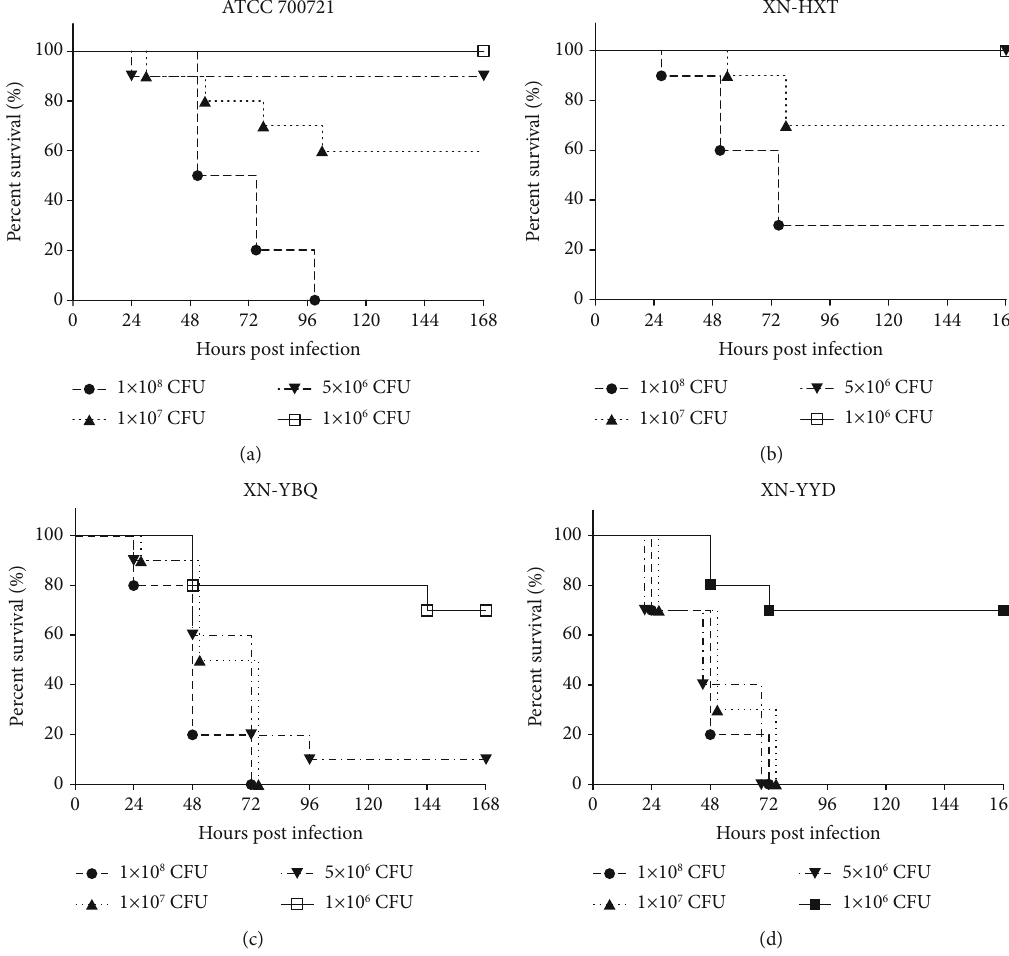
Figure 1: The virulence of di ff erent strains of K. pneumoniae in mice. Mice ( n = 10 per group, data were collected from 2 separate experiments) were intratracheally administrated with 1 × 10 6 CFUs, 5 × 10 6 CFUs, 1 × 10 7 CFUs, and 1 × 10 8 CFUs of K. pneumoniae strain YBQ, YYD, HXT, and 700721, respectively. All mice were monitored for 7 days for survival rate